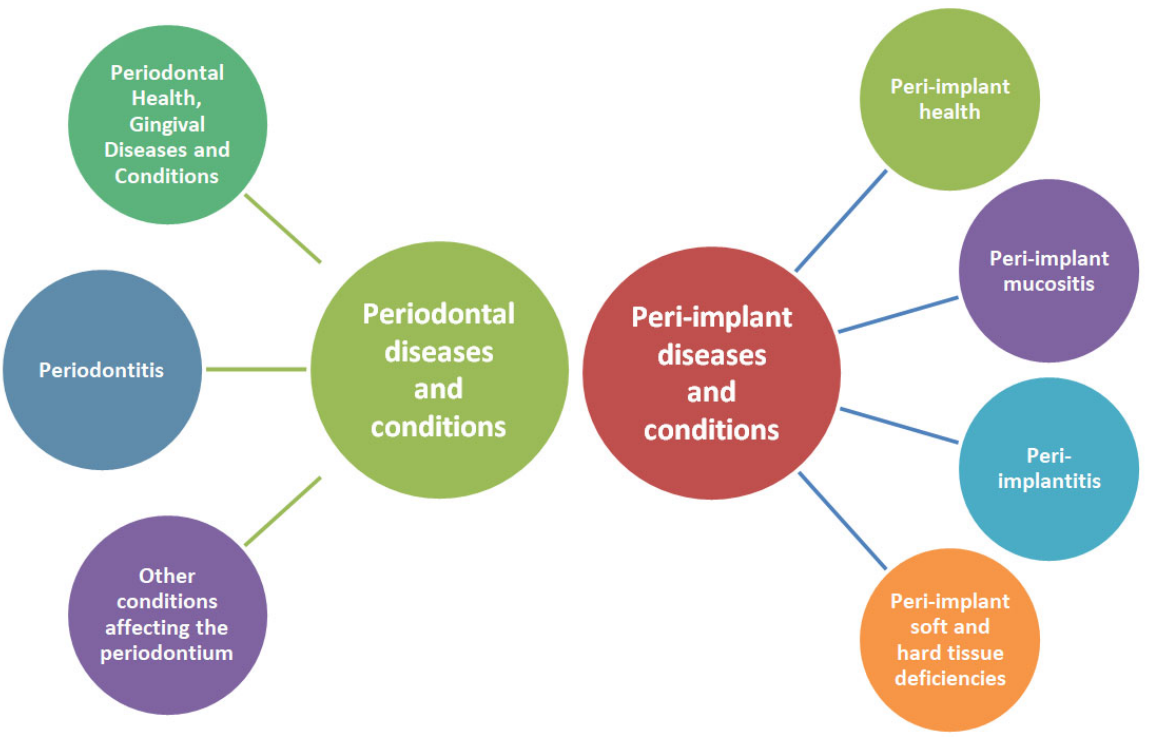
Figure 2. Schematic representation of the classification of periodontal and peri-implant diseases and conditions.